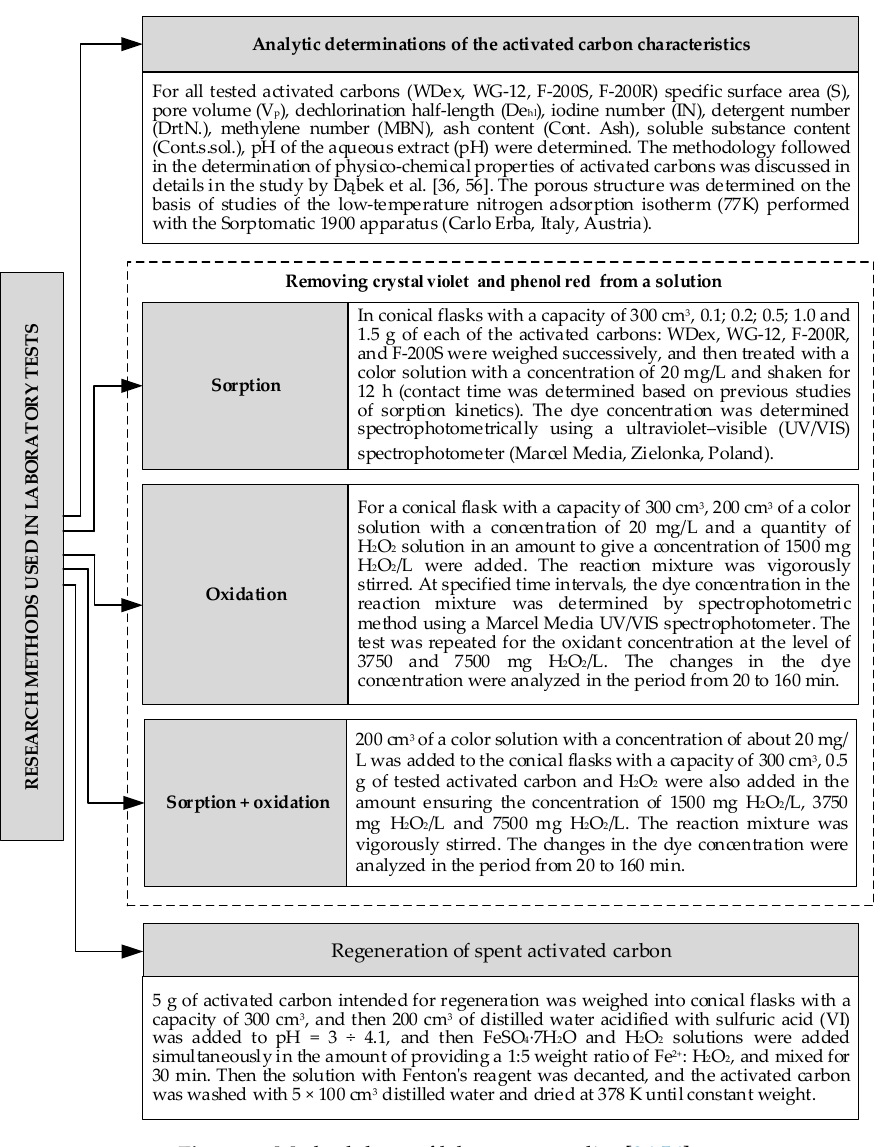
Figure 2. Methodology of laboratory studies [36,56].